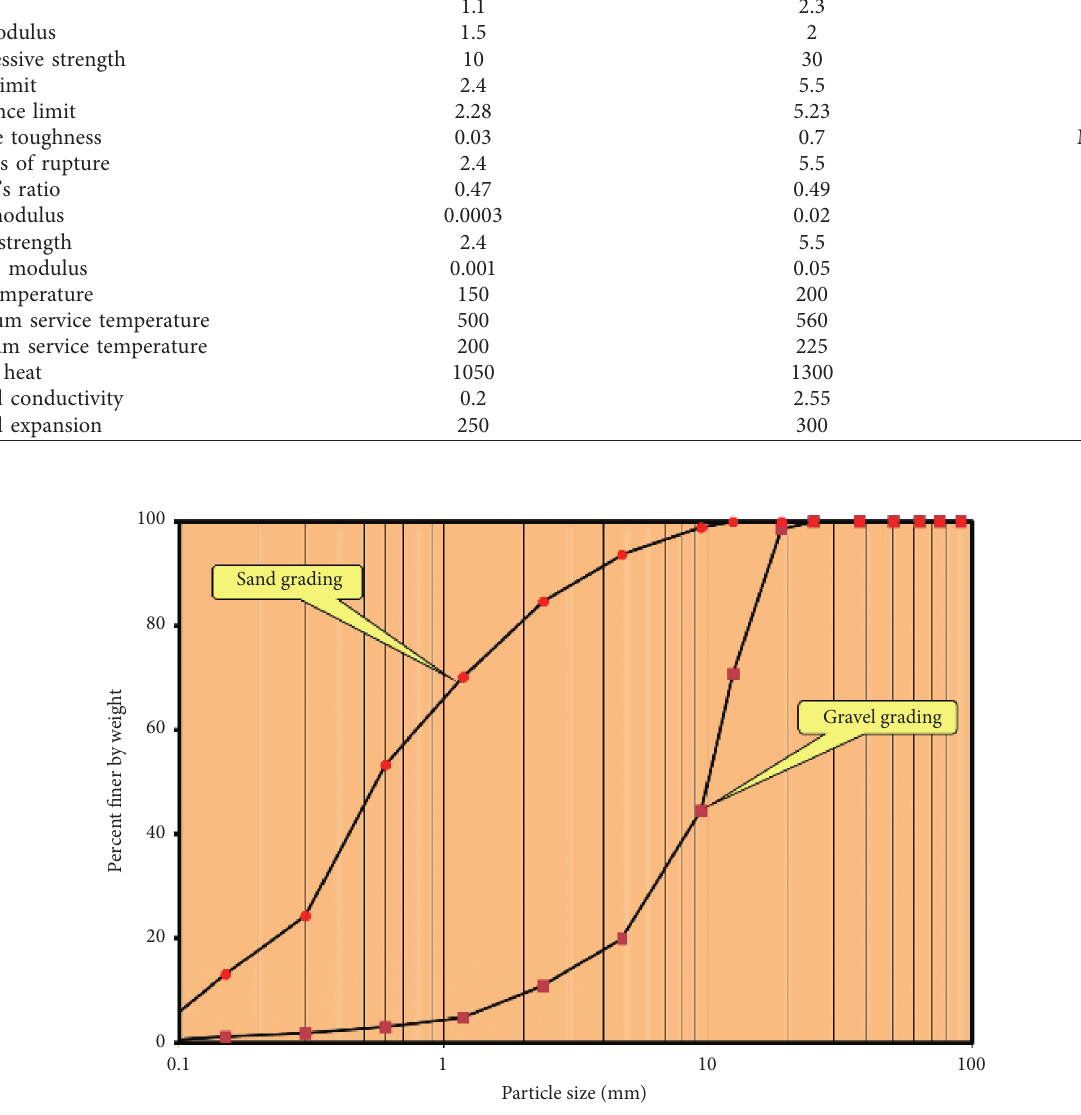
Figure 1: Gradation of mineral aggregates. Table 2: Properties of